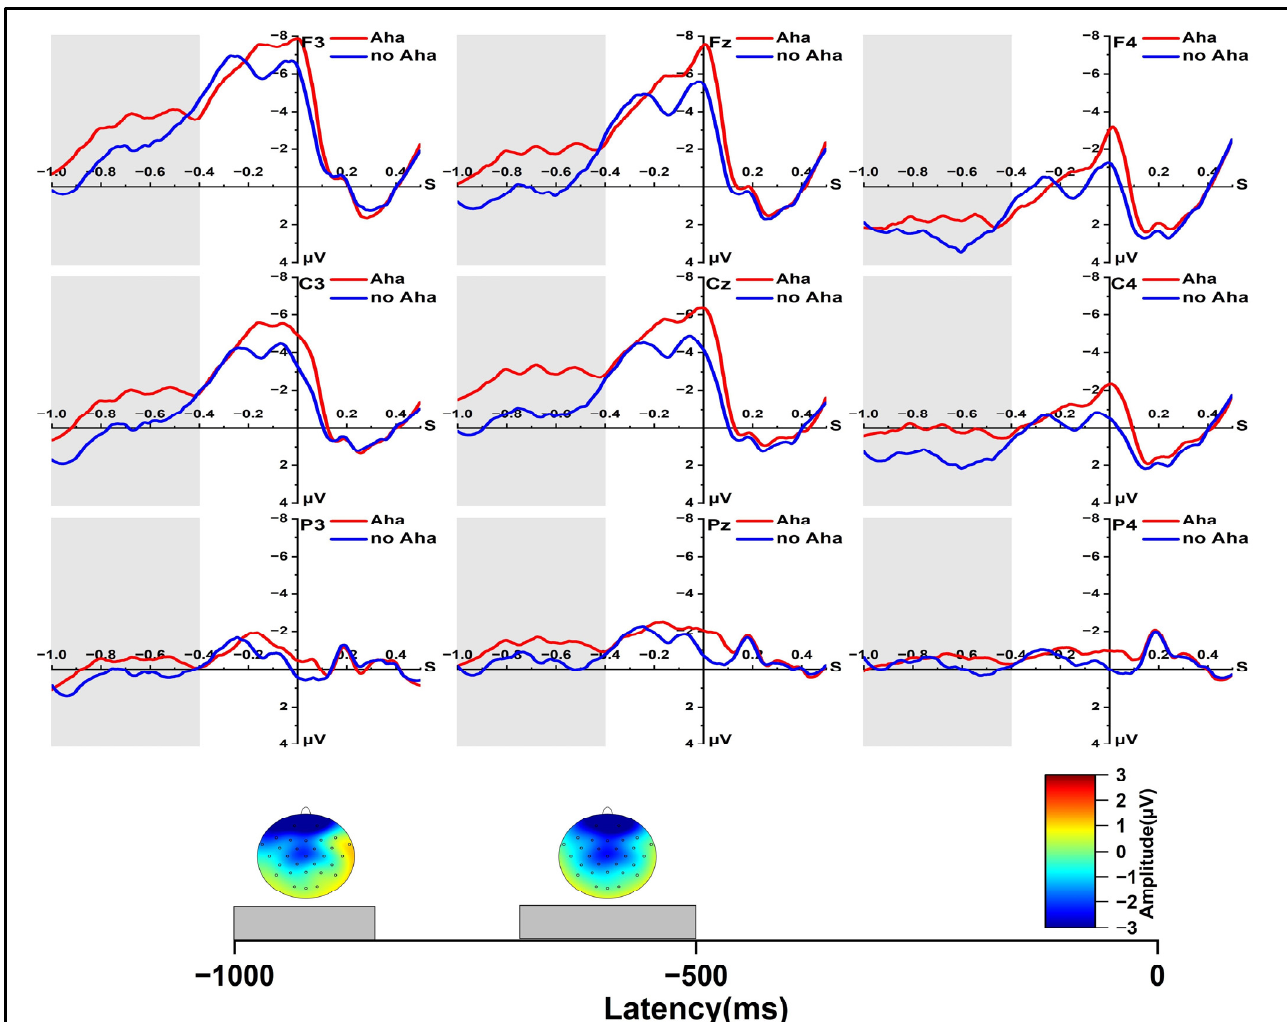
Figure 3. Grand-average ERPs from all selected channels for Aha and no Aha conditions and spher- ical-spline interpolated scalp distributions of the solution type (Aha minus no Aha) in − 1000 to − 700 ms and − 700 to − 500 ms time windows.